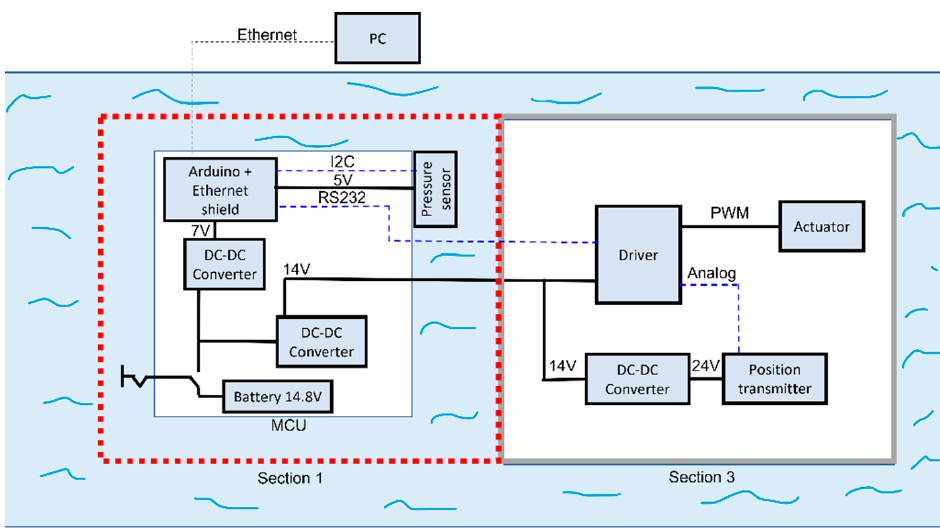
Figure 3. Measurement and control devices.